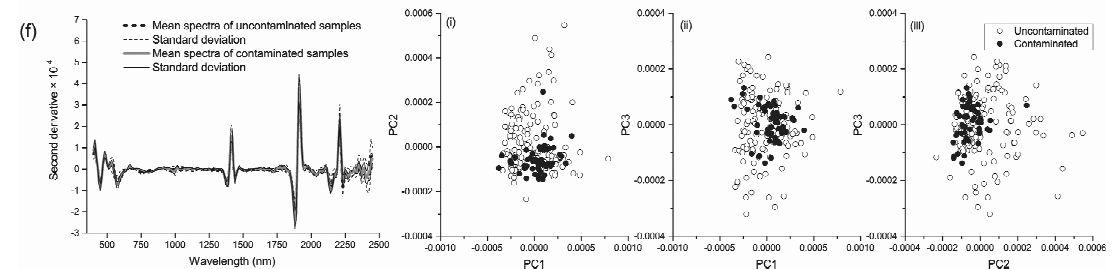
Figure 2. The reflectance spectra and the three first principal components (PC1, PC2 and PC3) for the contaminated and uncontaminated soil samples: ( a ) original reflectance spectra, ( b ) mean centering spectra, ( c ) standard normal variate spectra, ( d ) multiplicative scatter correction spectra, ( e ) first derivative spectra, and ( f ) second derivative spectra.